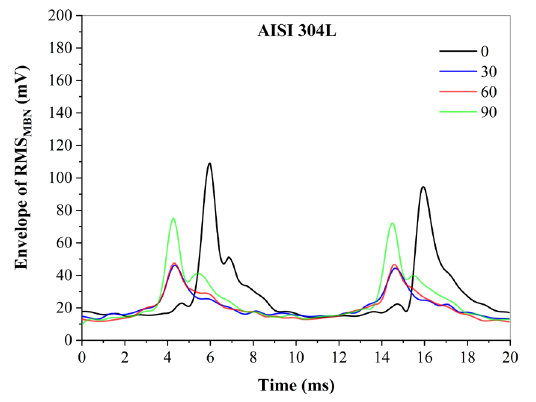
vs. time for 304L MBN